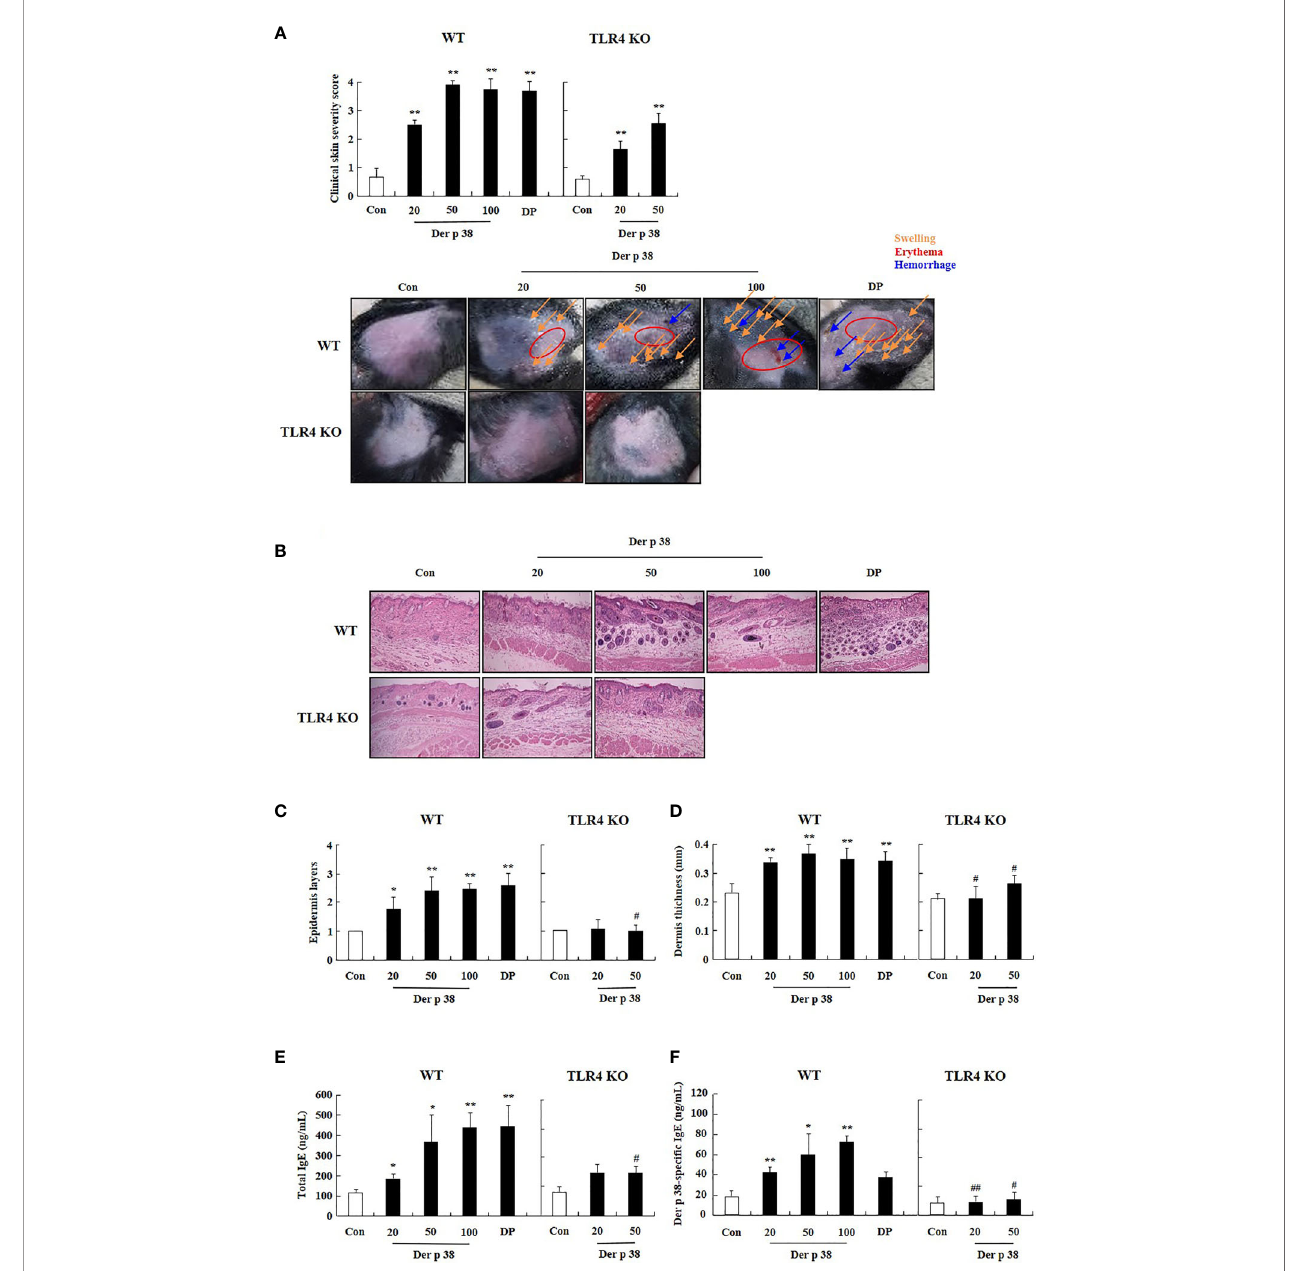
FIGURE 4 | Der p 38 induces AD-likephenotypes via TLR4 inthe mice. C57BL/10ScNJwild type (WT)and C57BL/10ScNJ TLR4 knockout(KO)mice were used inthis experiment. The mice were dorsally administered Der p 38 (20, 50, or100 m g/mice) orDP(100 m g/mice) using a 2 x 2 cm patch ofsterilegauze. The mice were wrapped with a band aid. After 6 days, the patch was removed,and 24 h later a new patch was applied,for a total of fi ve patches over a 5 weeks period.Clinical skinseverity score (A) , histologicalfeatures using hematoxylin and eosin stain (B) , layers of epidermis (C) anddermis (D) , totalIgE (E) , andDer p 38-speci fi c IgE (F) were evaluated as described in the Materials andMethodssection. The data are presented as a mean ± SD (n=3). * p < 0.05 and ** p < 0.01 indicatea signi fi cant difference between thecontrol group andstimulator-treated groups, and # p < 0.05 and ## p < 0.01 indicate signi fi cant differencebetween the WT andthe TLR4